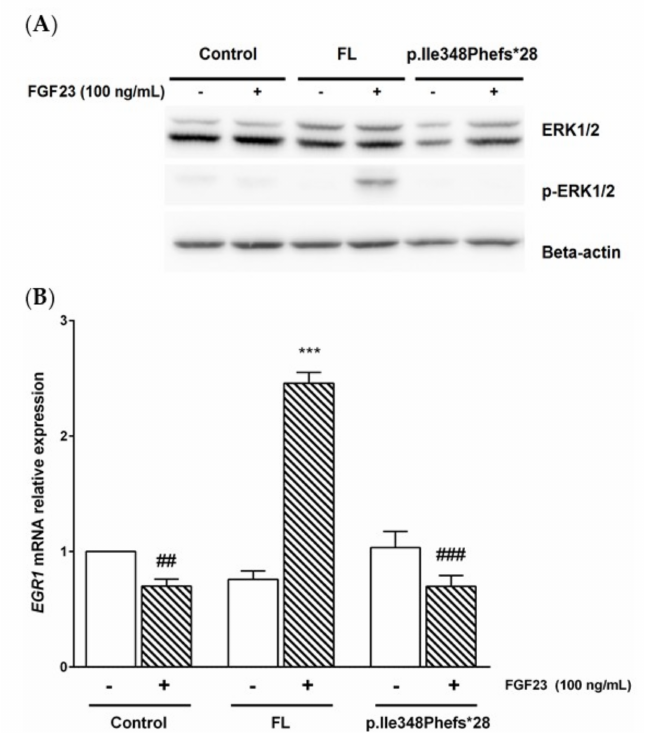
Figure 3. The p.Ile348Phefs*28 variant in KL gene impairs FGF23 signaling pathway. HEK293 cells were transfected with empty vector (Control), full-length (FL) or p.Ile348Phefs*28 KL gene variant and treated with vehicle (PBS with BSA 0.1%; − ) or recombinant FGF23 (100 ng/mL; +) for 60 min. ( A ) Immunoblot of total and phosphorylated ERK1/2 ( n = 3 for each condition). Molecular weights for ERK1, ERK2 and β -actin are, respectively, 44 kDa, 42 kDa and 45 kDa. ( B ) Relative EGR1 gene expression assessed by quantitative RT-PCR using GAPDH as the housekeeping gene ( n = 8 for each condition). Results are presented as fold change (mean ± SEM). *** p < 0.001 vs. vehicle, ## p < 0.01 or ### p < 0.001 vs. KL